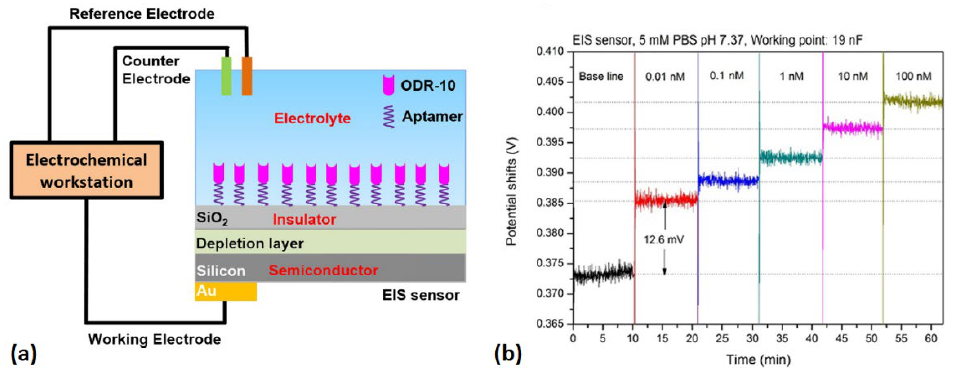
Figure 8. ( a ) Schematics of an EIS sensor using olfactory receptors for the detection of specific odor- ant. ( b ) Responses of this EIS sensor to different concentrations of odorant. (Reprinted with permission from ref. [63]. Copyright 2019 Elsevier).